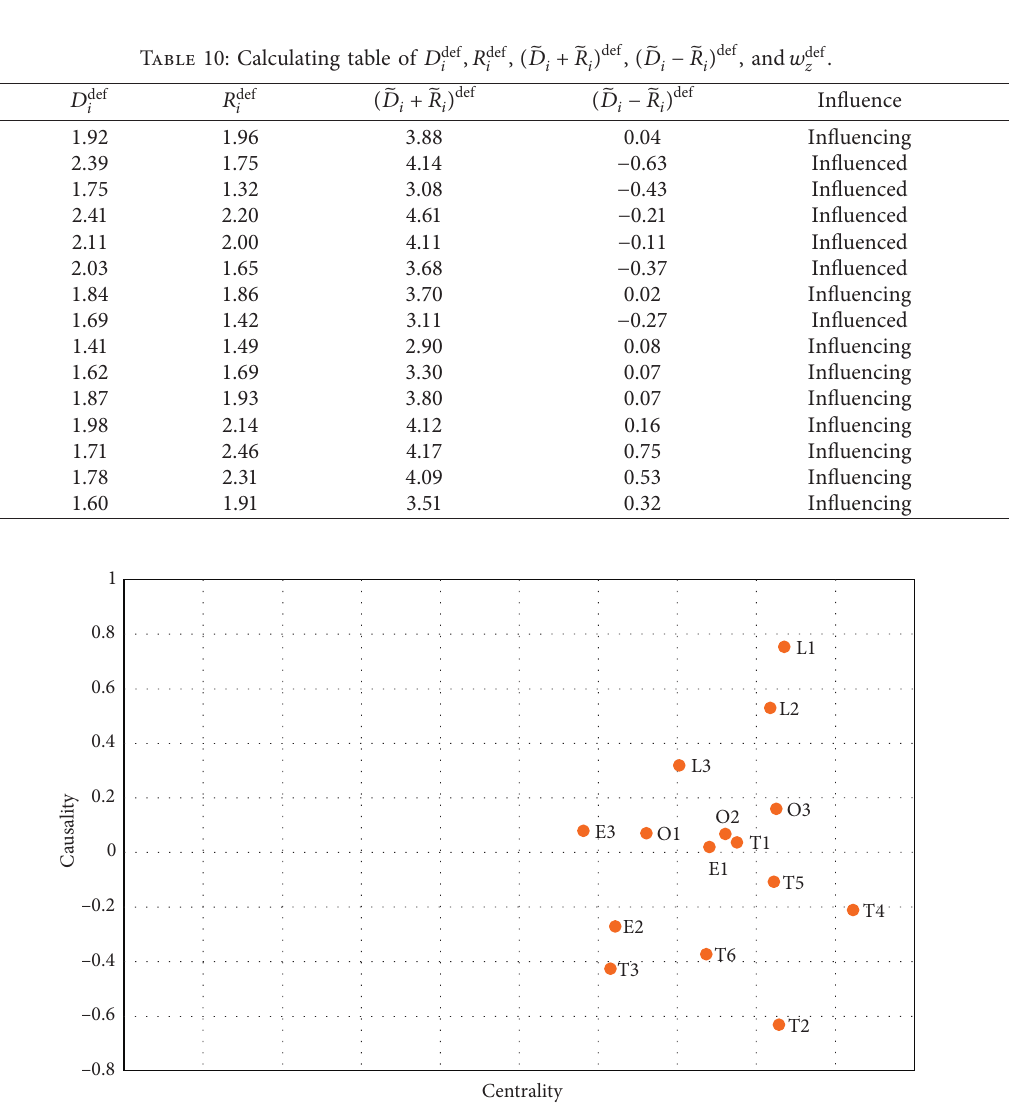
Figure 4: The causal diagram among various